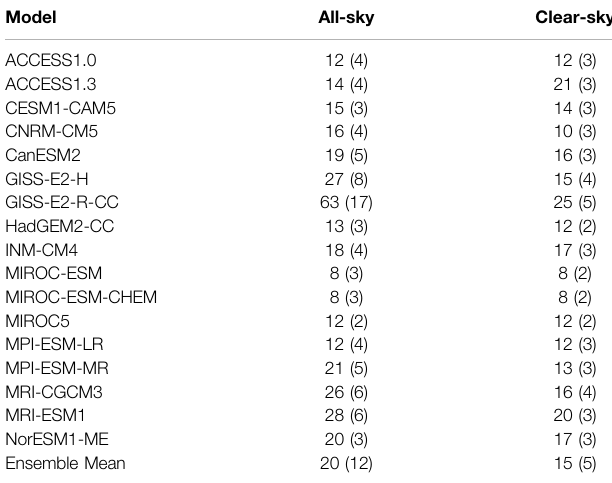
TABLE 5 | Mean TTE in years for all-sky and clear-sky SW acc trends from CMIP5 models. Model All-sky Clear-sky ACCESS1.0